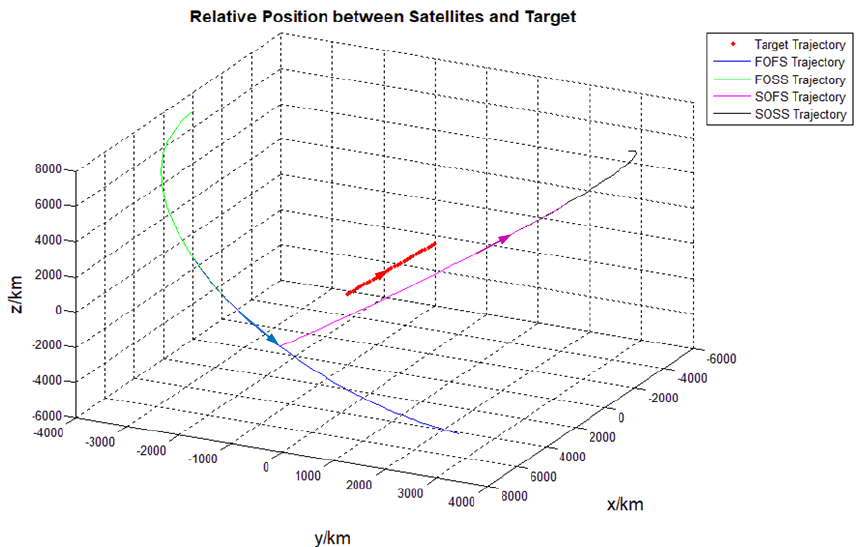
Figure 14. Selection of orbit planes and satellites for target1.